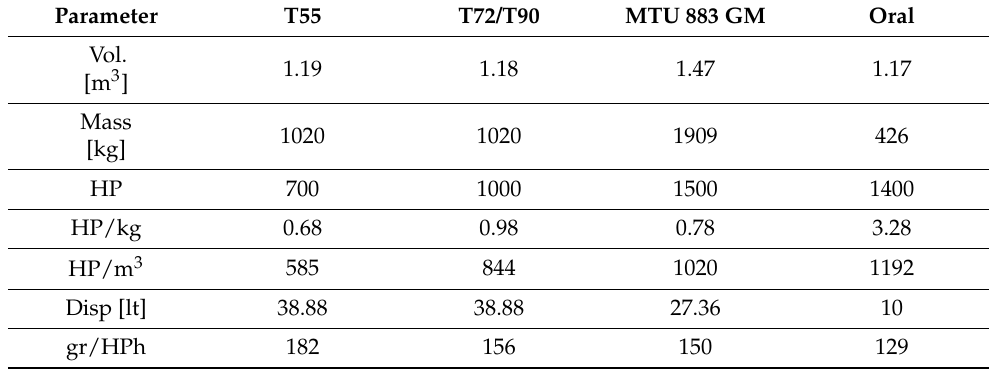
Table 1. Performance of an Automotive Traction Motor.